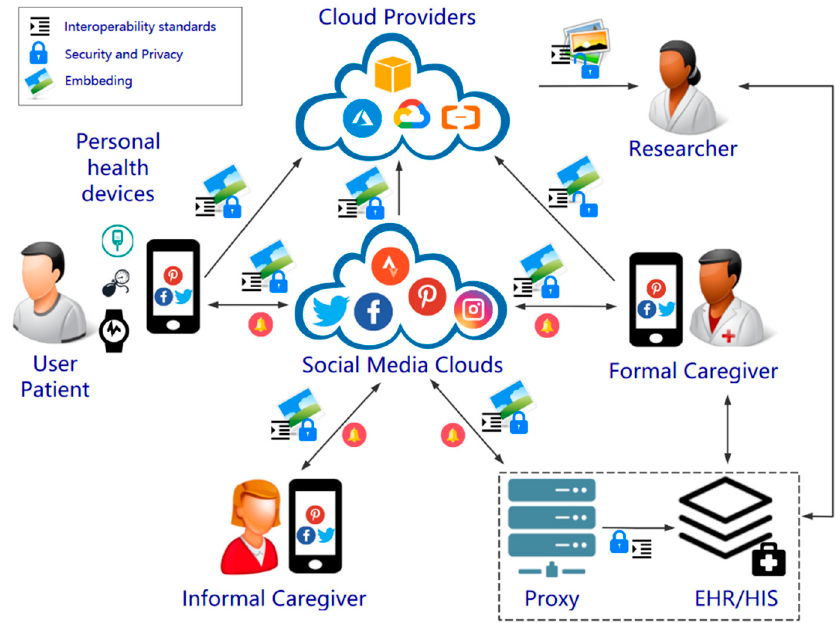
Figure 2. Proposal of the generic architecture.